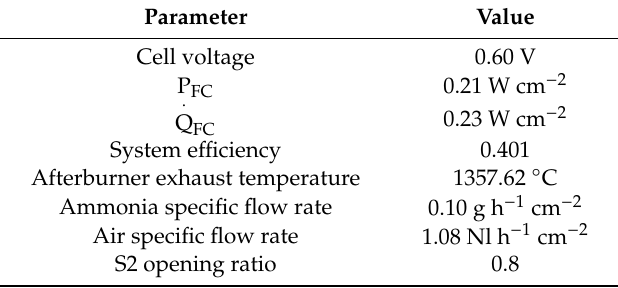
Table 3. System output parameters under nominal operating